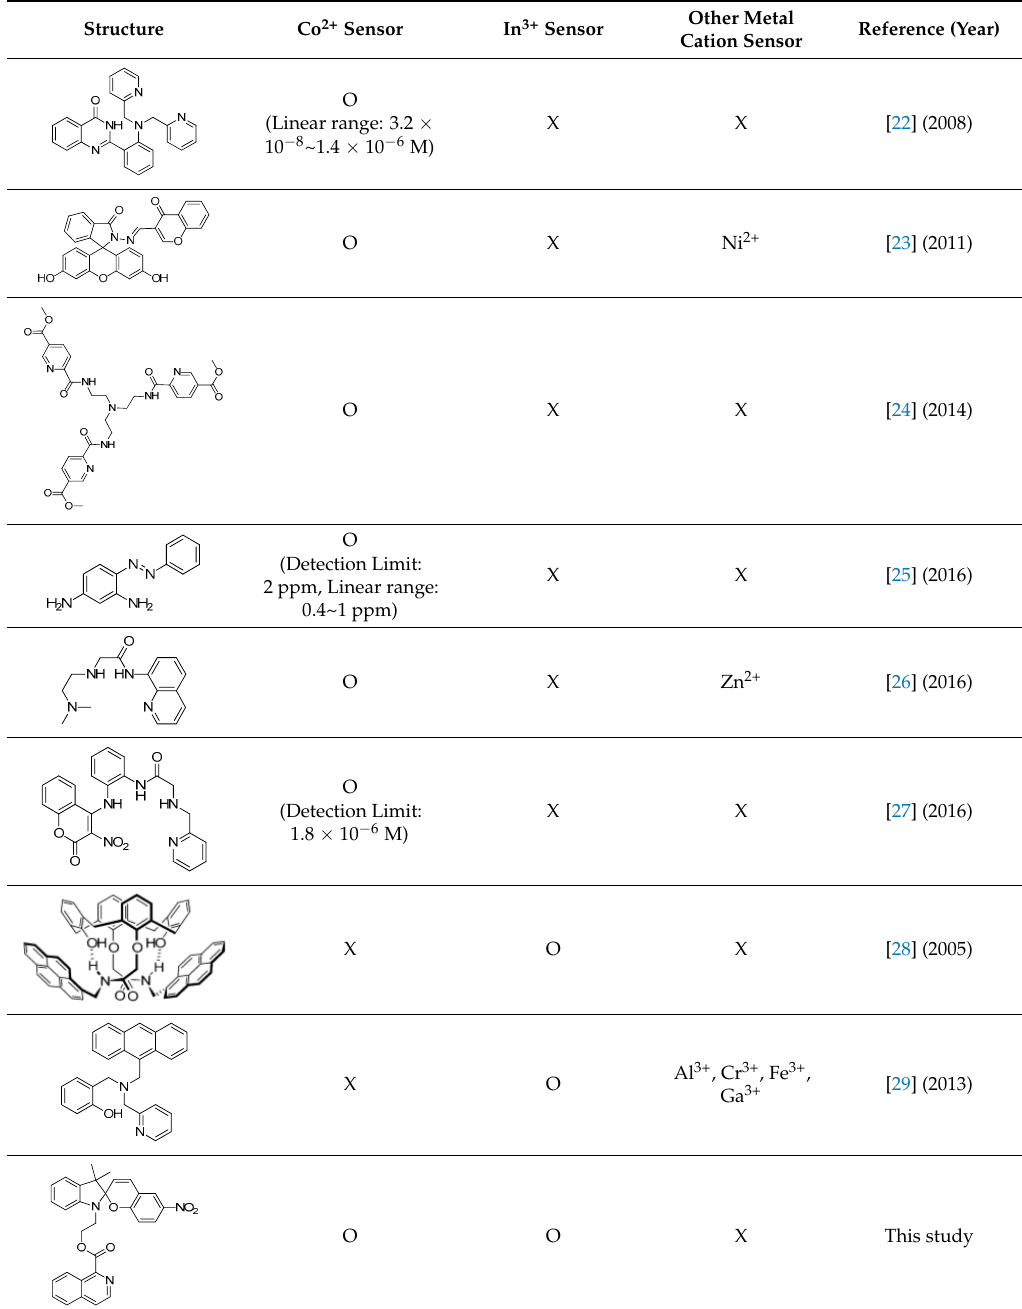
Table 1. Chemosensors for Co 2+ and In 3+ cations.